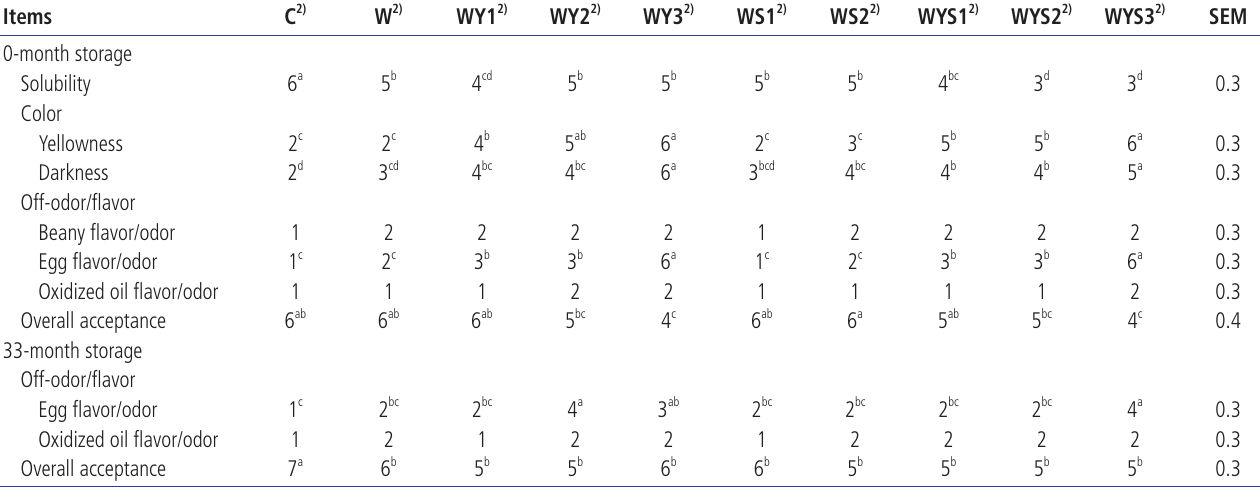
Table 7. The sensory evaluation 1) of non-dairy creamers with different formula and storage